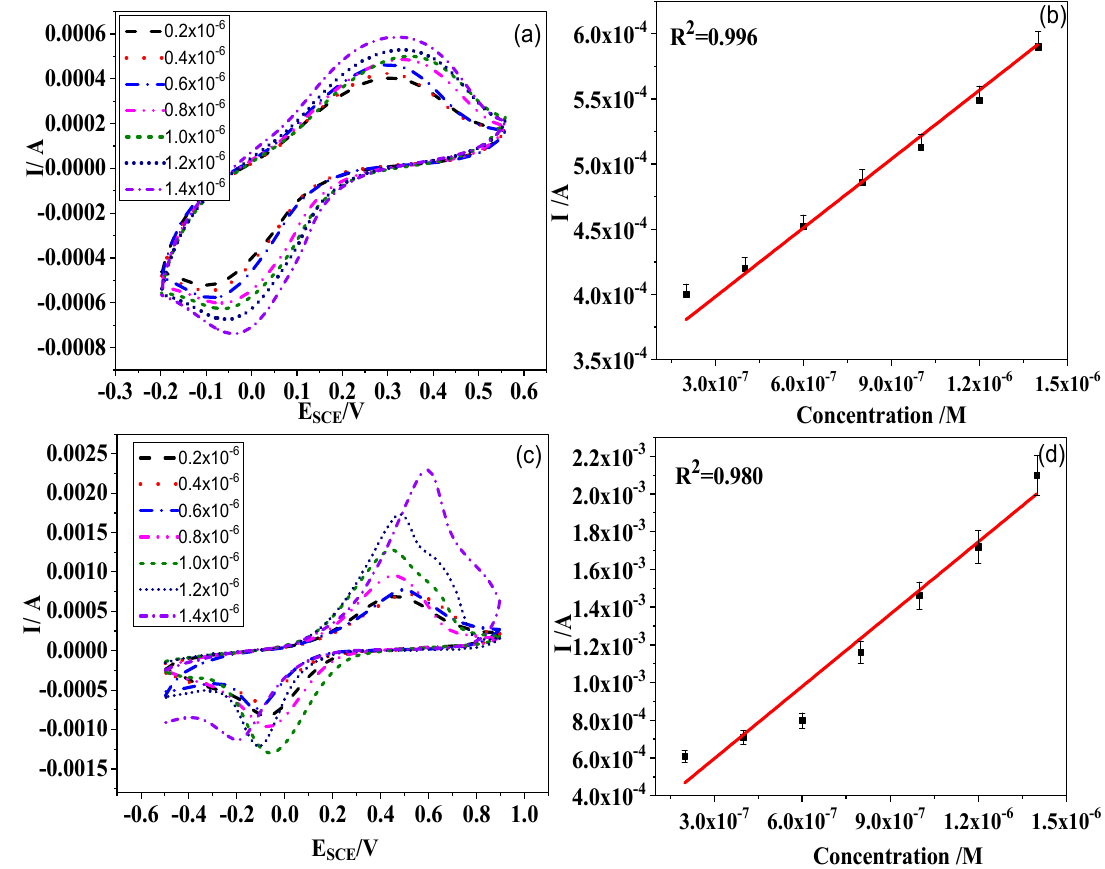
Figure 3. CV of ( a ) PACHA and ( c ) PANI at different concentrations of H 2 O 2 ; ( b , d ) show the calibration curve of PACHA and PANI with H 2 O 2 concentrations ranging from 2 × 10 − 7 to 4 × 10 − 6 M.